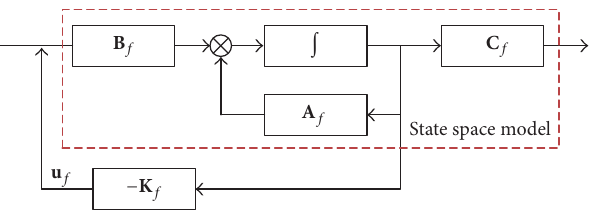
Figure 8: Optimal control block diagram of the fast subsystem.